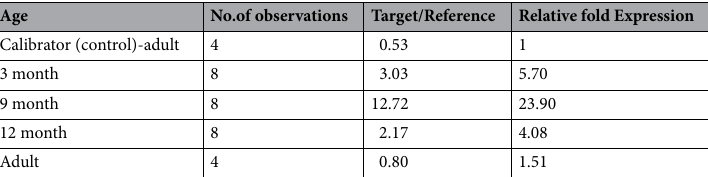
Age No.of observations Target/Reference Relative fold Expression